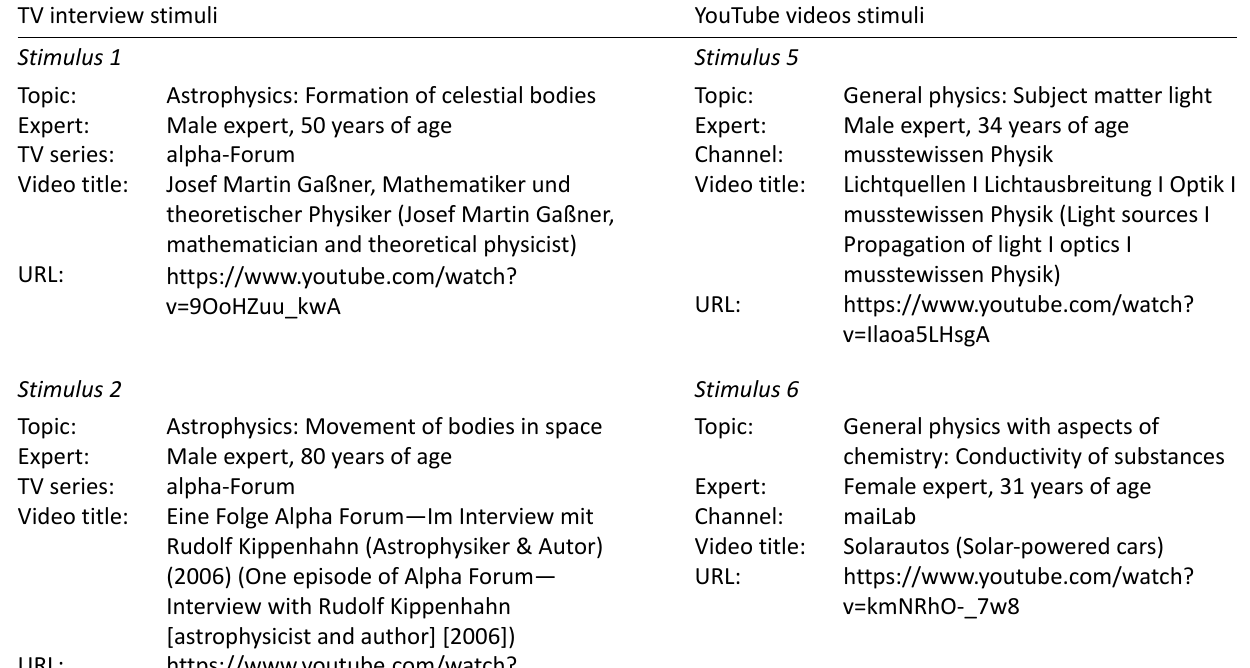
Table 1. Short description of video stimuli. TV interview